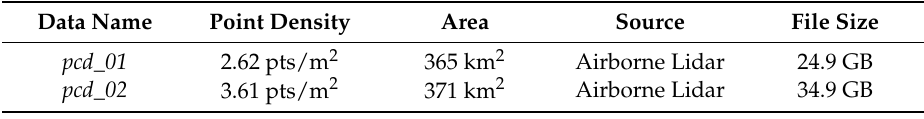
Table 3. Basic information about experimental LiDAR point clouds.